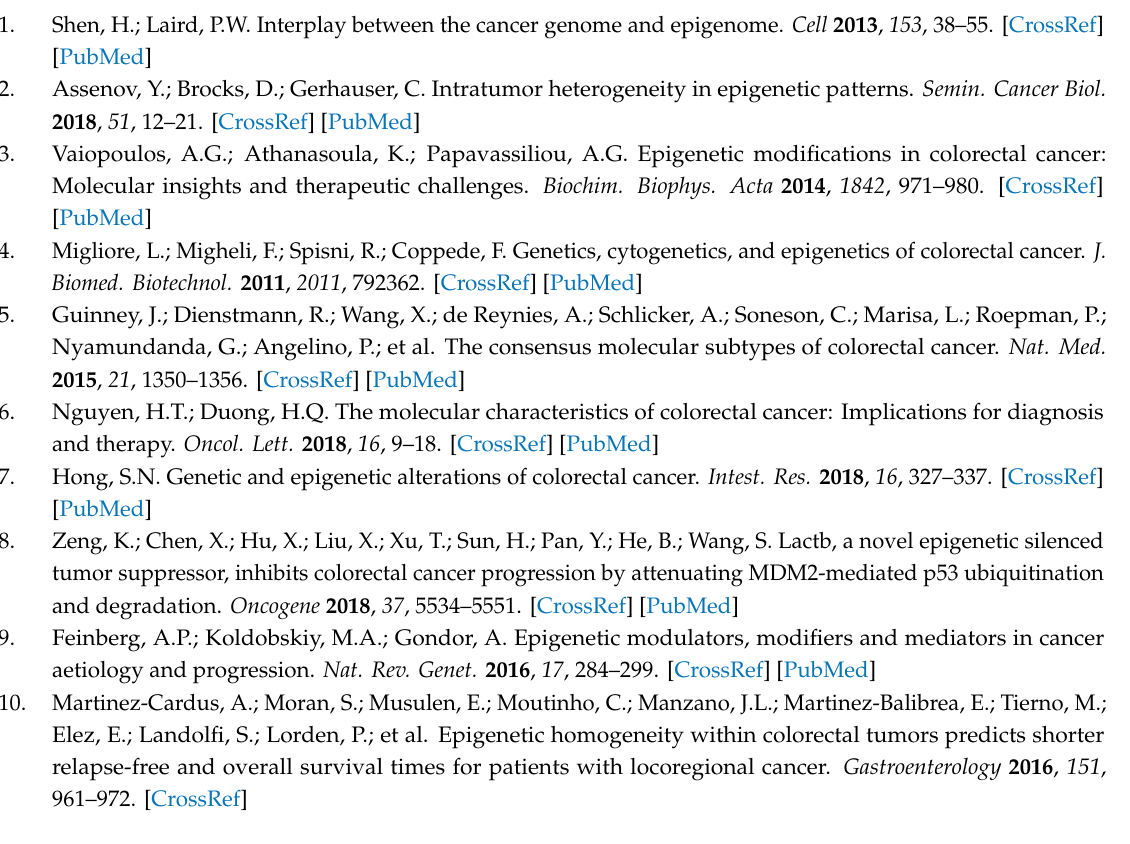
s1. Table S1: LncRNAs sponging microRNAs in CRC. Figure S1: Overview of cross-talk between gene-regulatory layers in CRC (A vector graphics